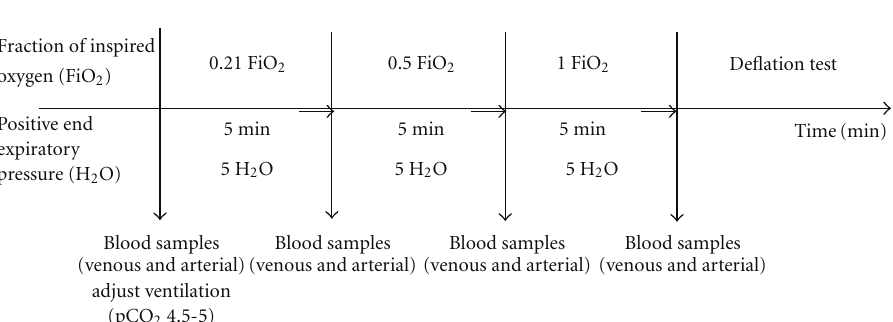
Figure 5: Photograph of the preparation of the donor lungs for ex vivo treatment showing cannulation of the pulmonary